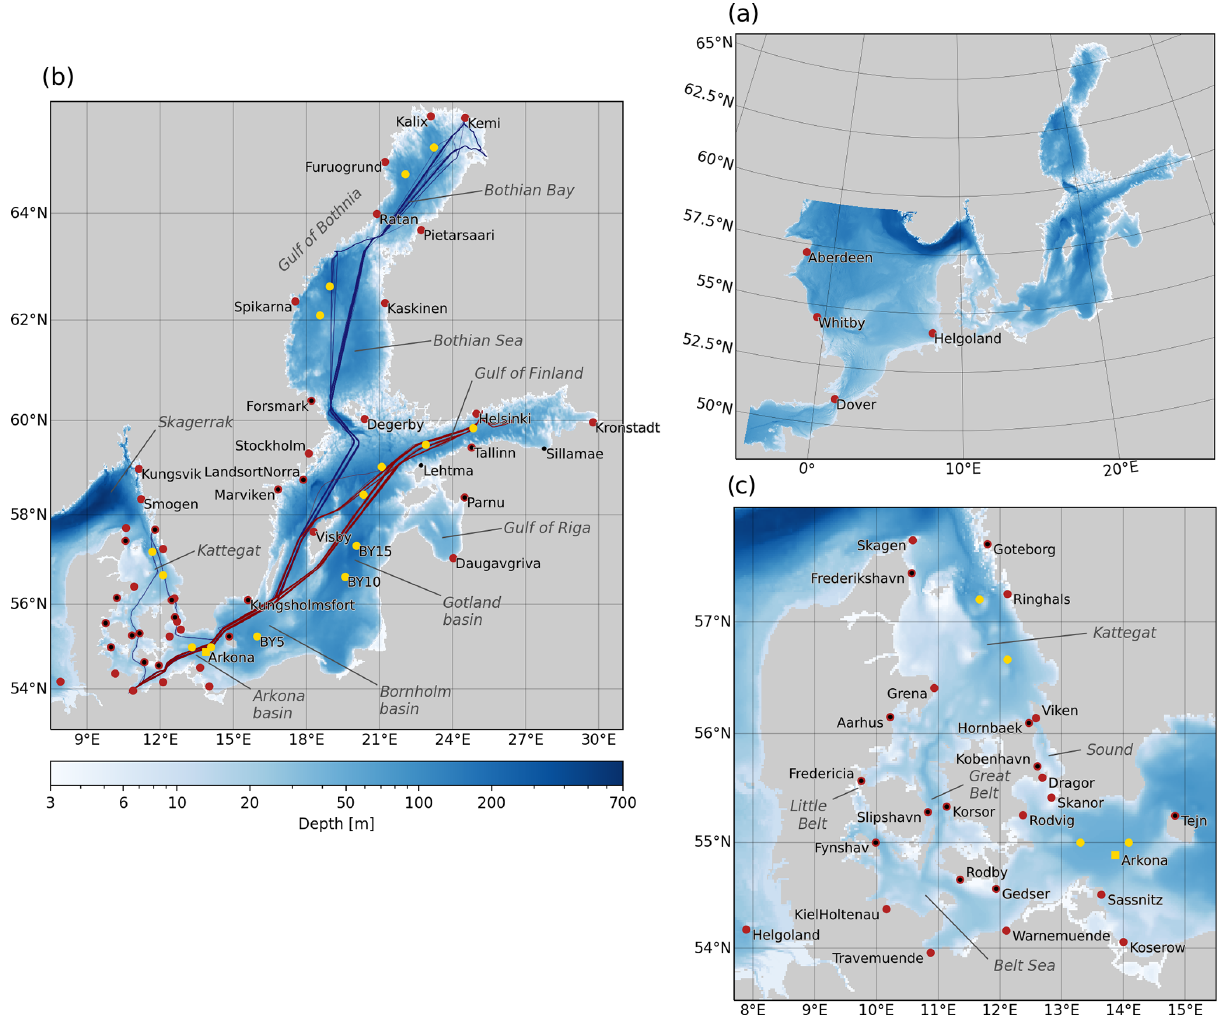
Figure 1. Computational domain and bathymetry; (a) the entire model domain, (b) the Baltic Sea, and the (c) Danish Straits region. Red and black dots indicate station locations with SSH and SST observations, respectively; yellow dots indicate vertical profile locations. Blue and red lines illustrate the TransPaper and FinnMaid ferry routes,